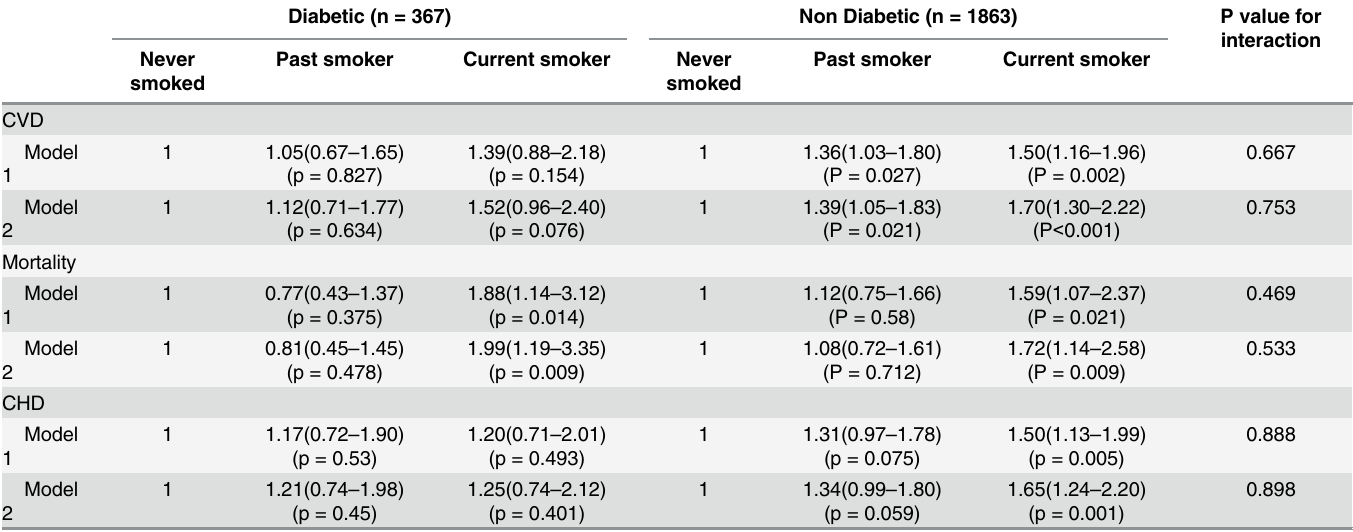
Table 2. The risk of different smoking groups between diabetics and non-diabetics participants for cardiovascular and coronary heart diseases and all-cause mortality. Tehran Lipid and Glucose study (1999 – 2012).